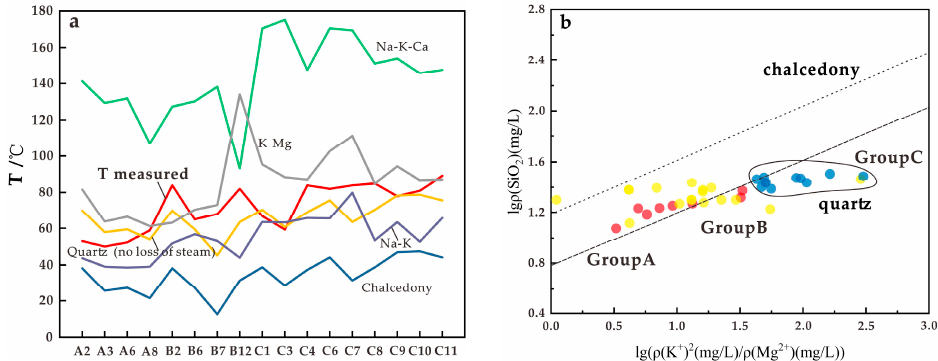
Figure 8. ( a ) Comparison between the measured results of different geothermometers; ( b ) comparison chart of Lg(SiO 2 ) vs. Lg(K 2 /Mg).